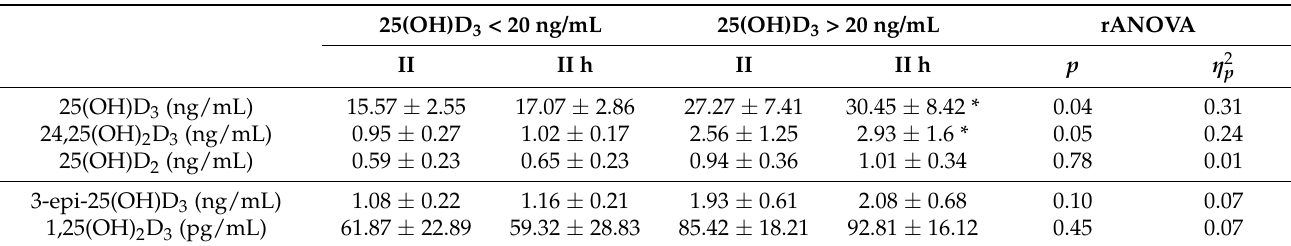
Values are means ± SD. II, after 8 d of fasting; II h, after 8 d of fasting, 1 h after exercise. *—statistically significant differences (by repeated-measures analyses of variance with post-hoc tests), η 2 p —the effect